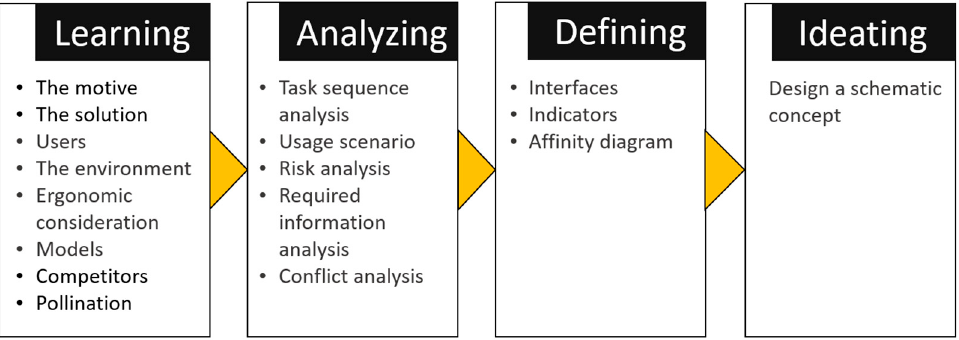
Figure 4. Usability